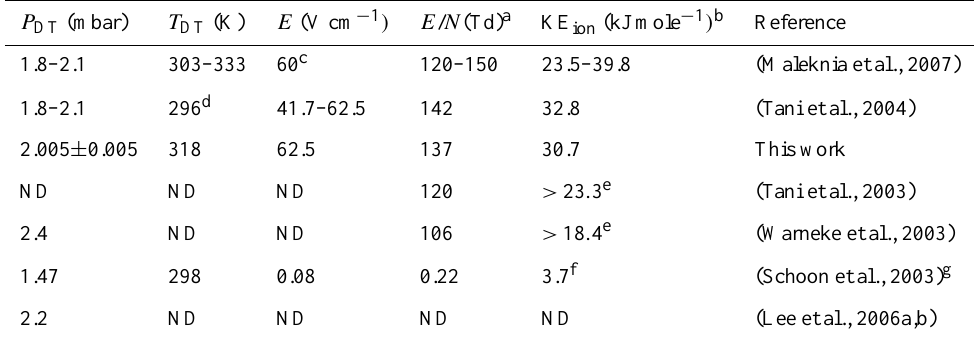
Table 6. Comparison between PTR-MS operating parameters employed at THF during summer of 2004 and in selected studies reported in the